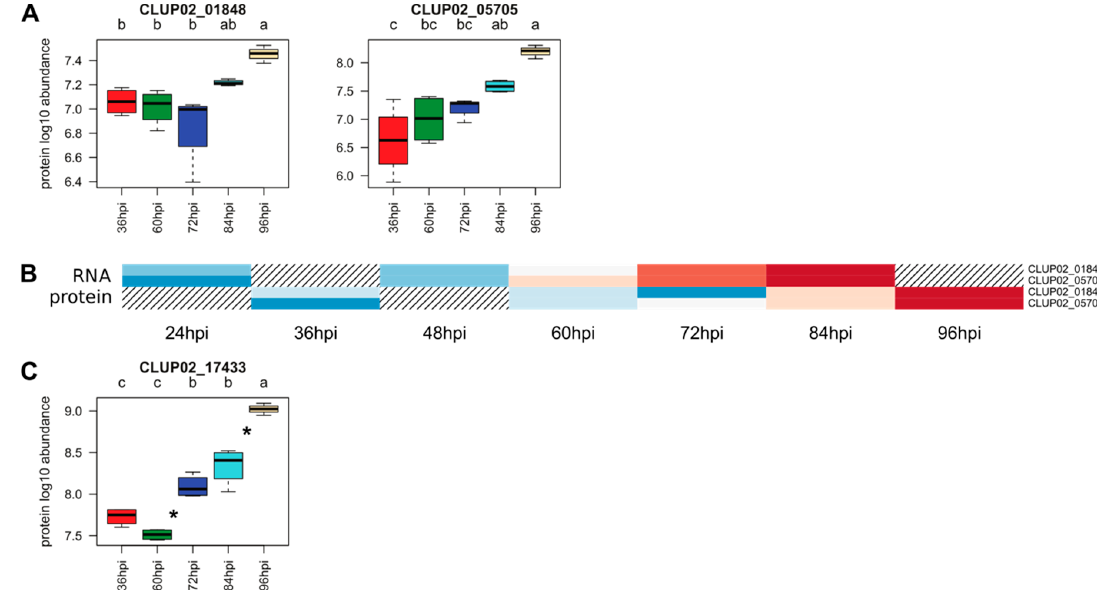
Figure 8. Overview of C. lupini expression and synthesis of genes and proteins associated with secondary metabolism and transcription factors. Boxplots showing the mean abundance of proteins associated with secondary metabolism from four biological repetitions and quantified by mass spectrometry. ( A ). Heatmap of the two proteins associated with secondary metabolism regarding their abundance and the corresponding transcript expression profile. Hatching areas indicate that data are not available ( B ). Boxplots showing the mean abundance of the transcription factor from four biological repetitions quantified by mass spectrometry. ( C ). Colored bars indicated gene expression by Z-score calculated from normalized reads, and ranging from − 2 (downregulated gene, blue) to 2 (upregulated gene, red), or protein abundance by Z-score calculated from protein log10 abundance, and ranging from − 2 (lowest abundance, blue) to 2 (highest abundance, red). Asterisks between histograms indicate significant changes over time.